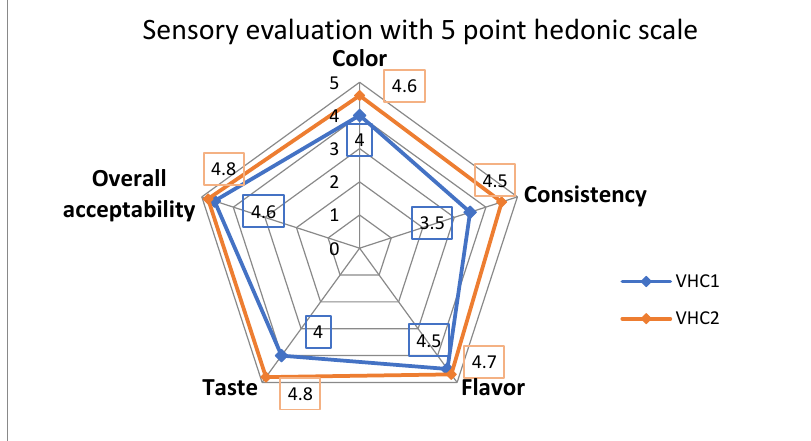
Figure 6. Global values of the sensory evaluation of VHC1 and VHC2 by using a 5-point hedonic scale.